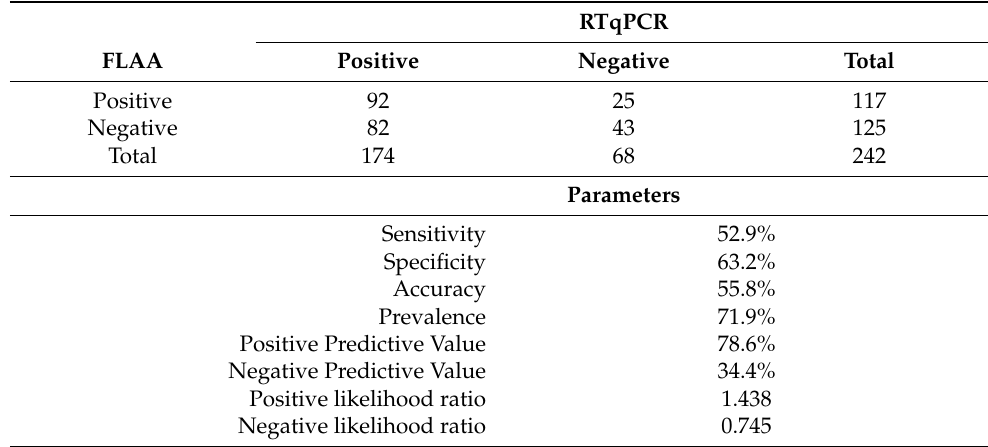
Table 2. Tetrachoric table for the determination of diagnostic parameters.